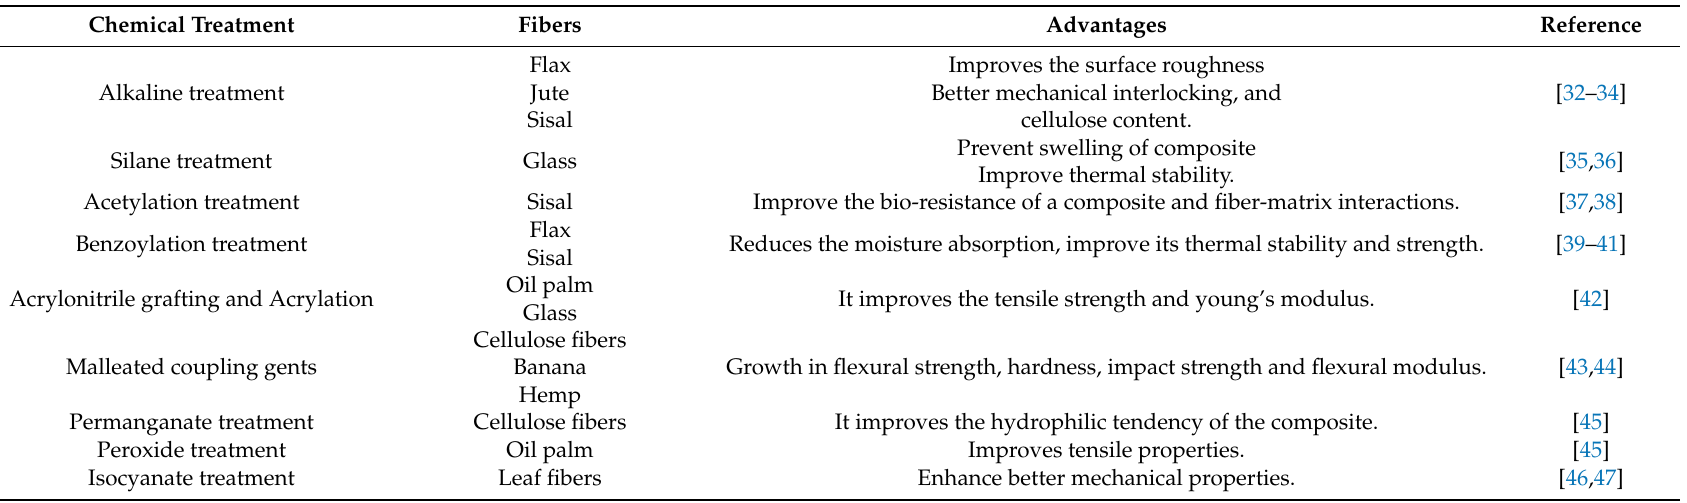
Table 6. Chemical treatment processes and its importance on hybrid fiber